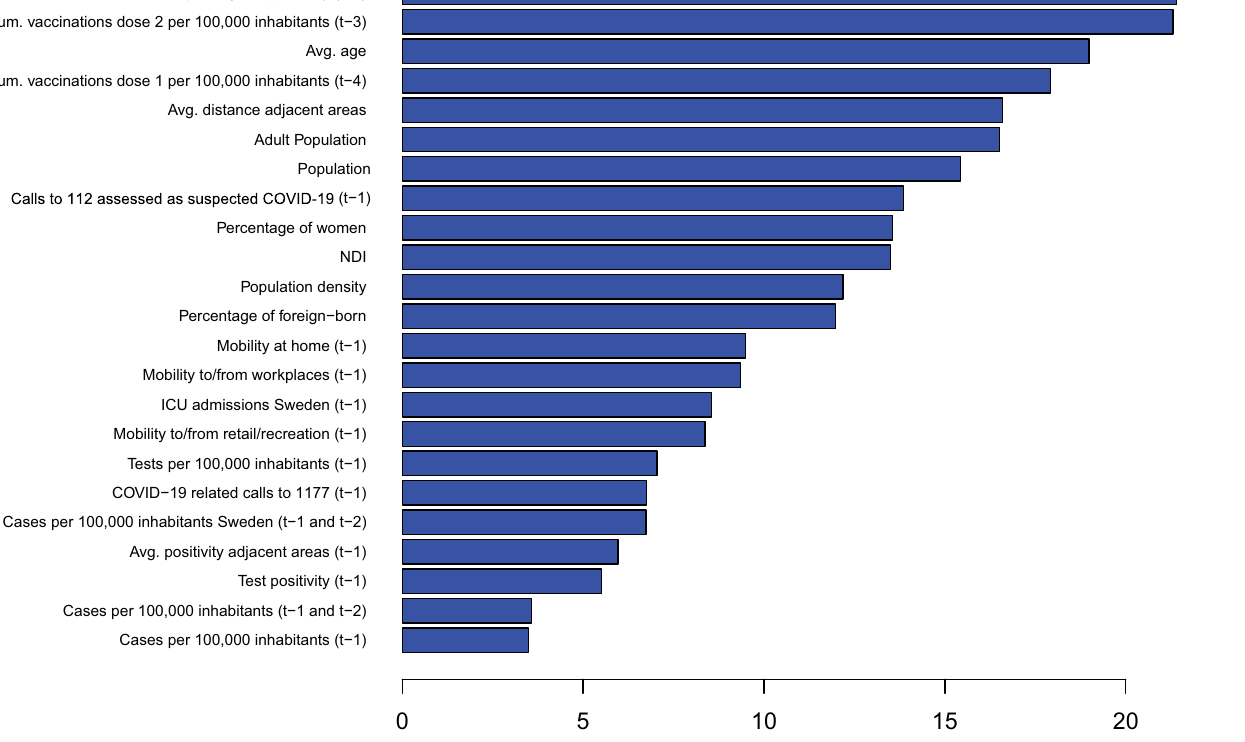
Figure 2. Means of the importance ranks over all time points for the Random Forest model. Lower ranks indicate higher